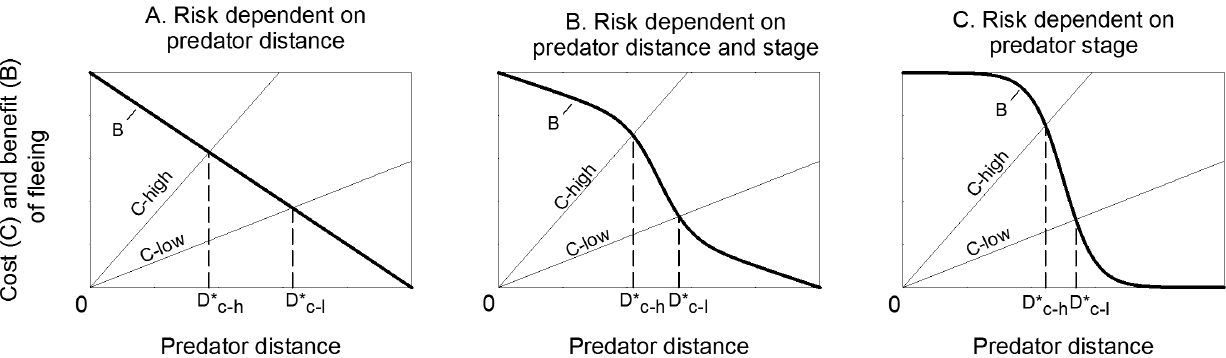
Figure 7. Cost-benefit models of escape behavior with varying prey knowledge of predator attack stage. Prey cost of fleeing C is dependent on predator distance and prey characteristics (C-low vs. C-high). In the classic model (panel A), benefit of fleeing B is equal to predator risk and increases as the predator gets closer (modified from [1]). The optimal escape distance D* occurs at the intersection of B and C. We propose that this model holds for prey that lack information about predator attack stage. For prey with information about predator attack stage (panel C), B is predicted to be a sigmoidal function with an increase in risk/benefit of fleeing when the predator detects a target and commits to an attack (see Figure 1). Partial information on predator stage has a risk function that is a combination of predator distance and attack stage (panel B). Increased availability of information on predator stage diminishes the effect of prey cost level (C-high vs. C-low) on optimal escape distance D*.